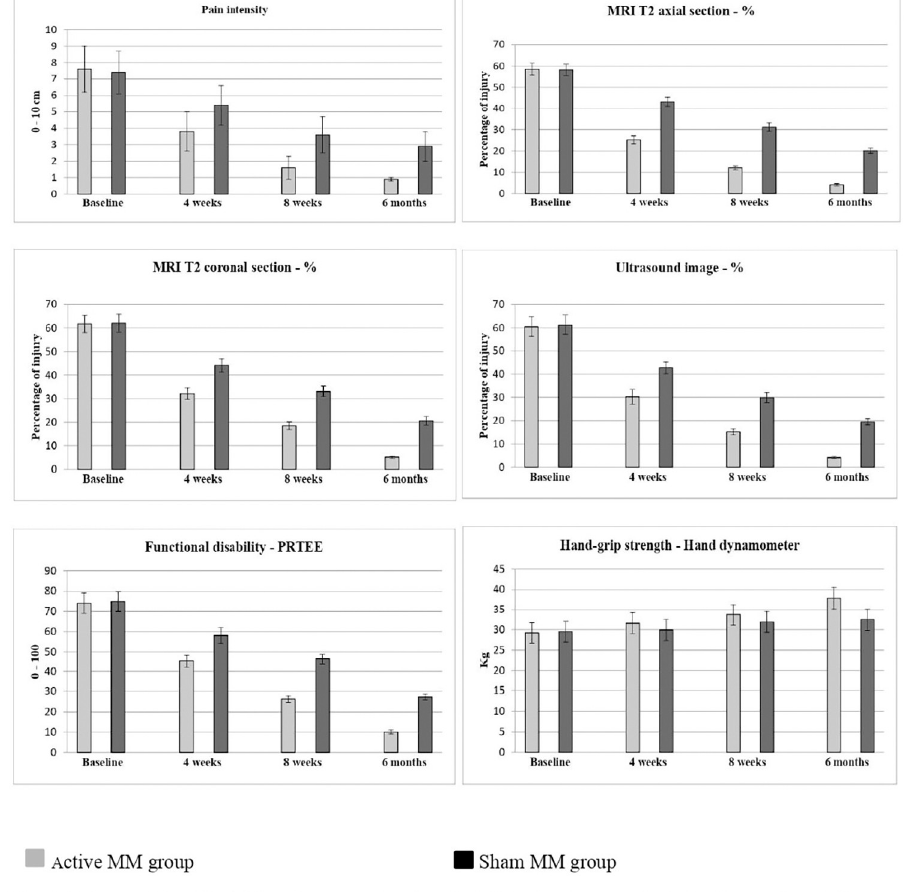
Fig 3. Pre and post primary outcome measures of active and sham MM